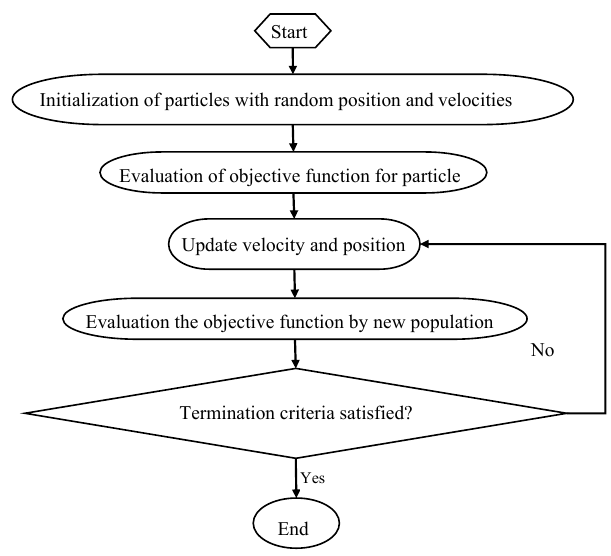
Figure 3. Schematic representation of the optimization rationale for for particle swarm optimization (PSO).